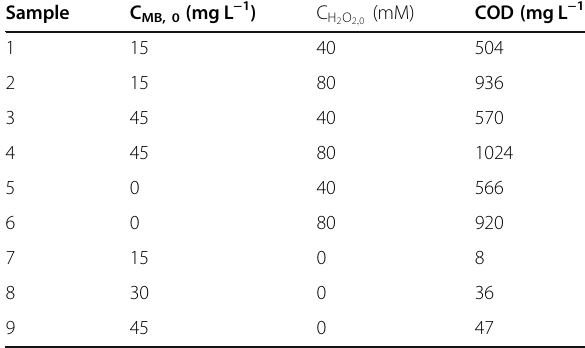
Table 4 COD values for standard samples